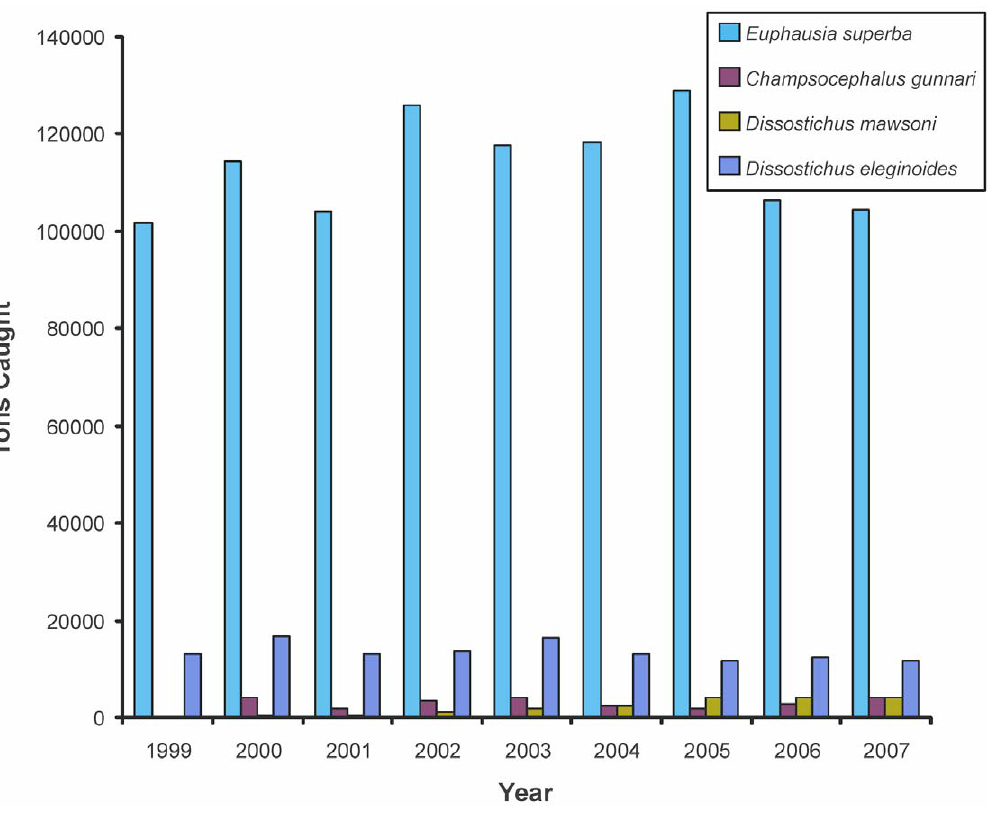
Figure 8. Southern Ocean fisheries catch data. The Commission for the Conservation of Antarctic Marine Living Resources (CCAMLR) catch statistics (in tons) for the major commercially caught species in the Southern Ocean from 1999 to 2007.